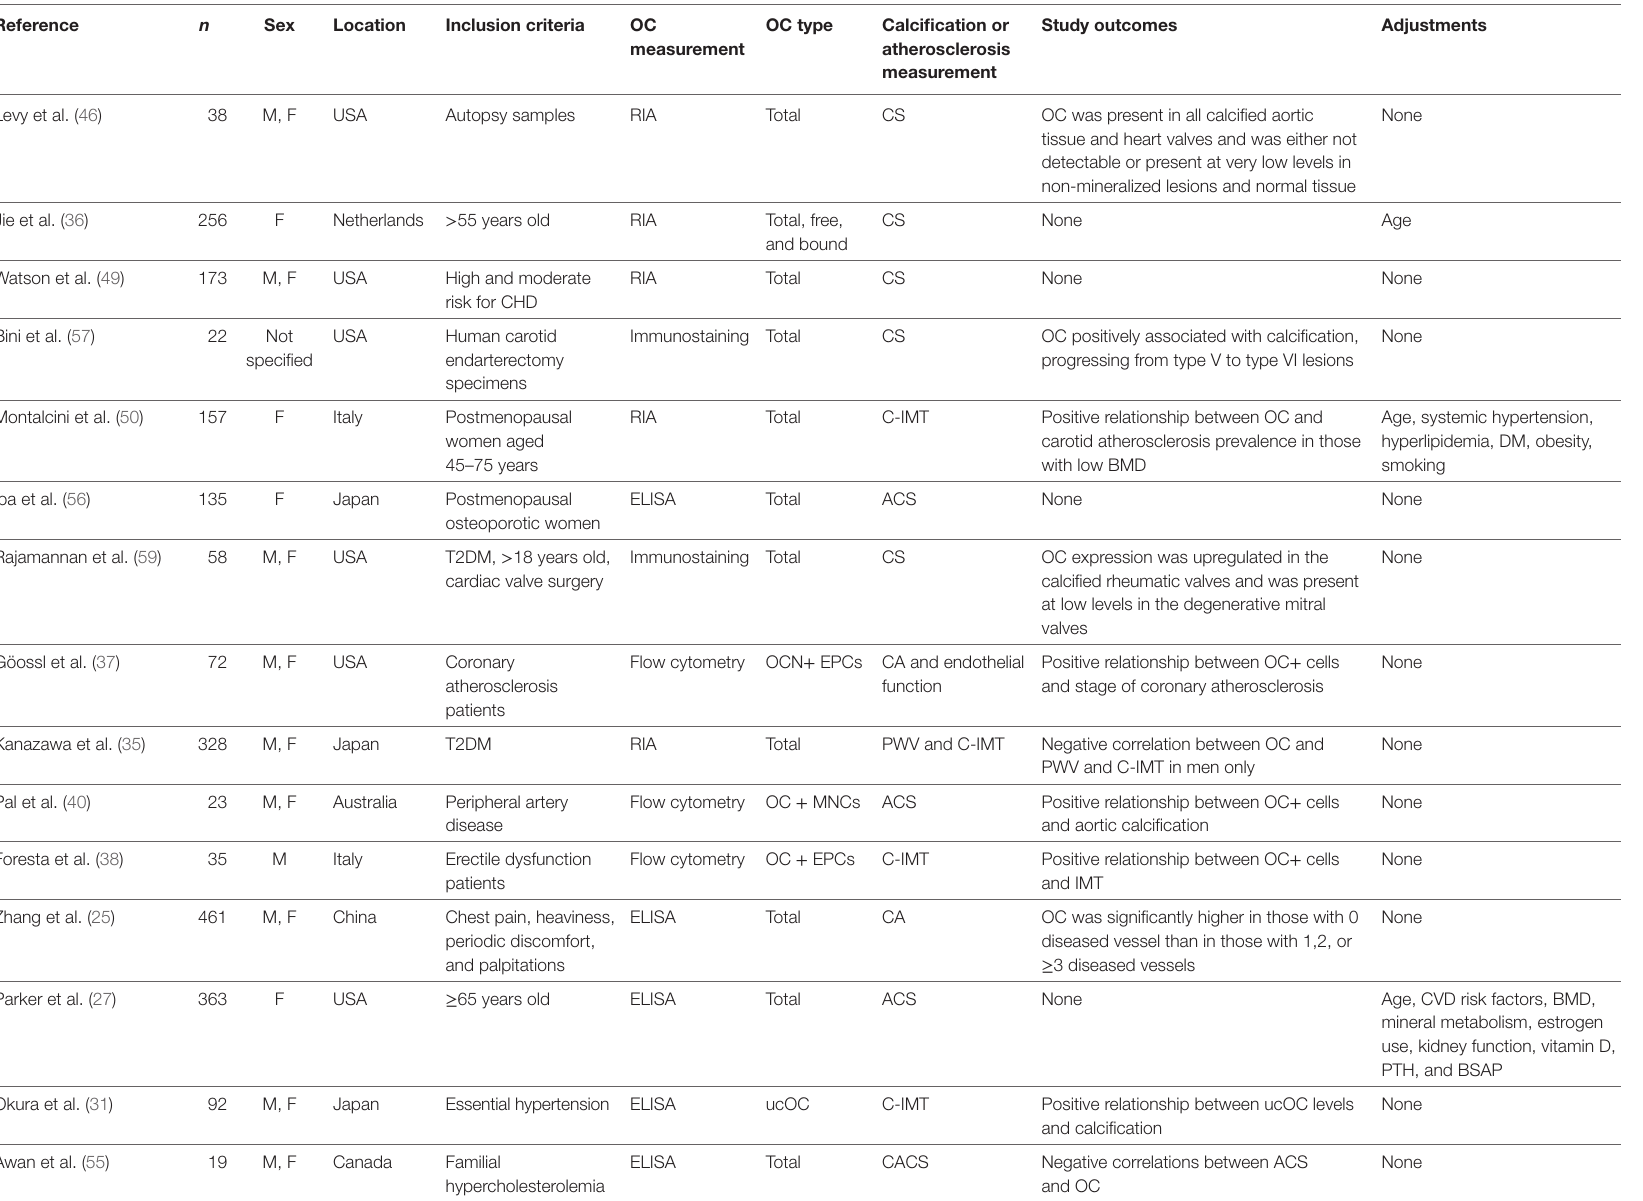
taBLe 1 | Summary of included